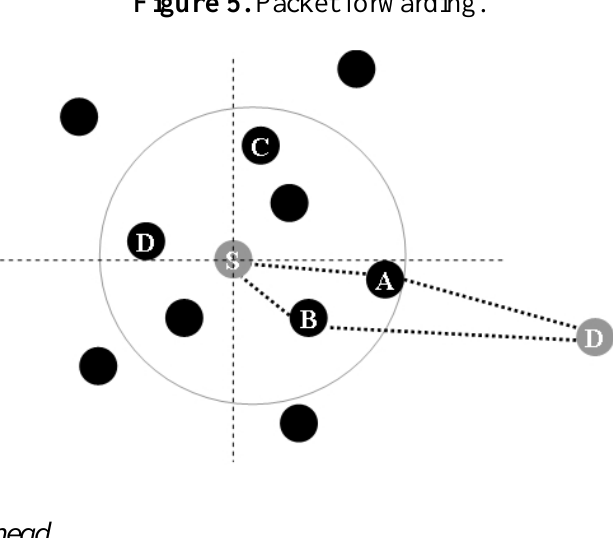
Figure 5. Packet forwarding.